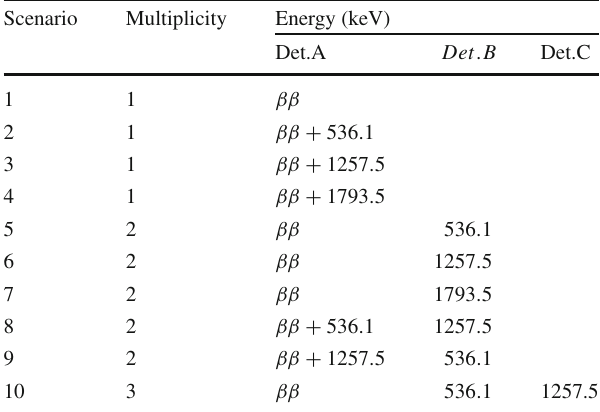
Table 1 Allowed scenarios for the most likely de-excitation pattern (two gammas with energies of 1257.5 keV and 536.1 keV), resulting from the rules defined in Sect. 3.1. The decay always takes place in detector A. ββ , which represents the energy deposited by electrons, corresponds to 734 keV for the 0 νββ decay and to any energy in 0 + 1 the 0 ÷ 734 keV range for the 2 νββ decay. An energy deposition of 0 + 1 1793.5 keV is recorded when both gammas deposit their energy in the same crystal. Scenarios where only one crystal is involved (Multiplicity 1) are valid only for 0 νββ 0 +